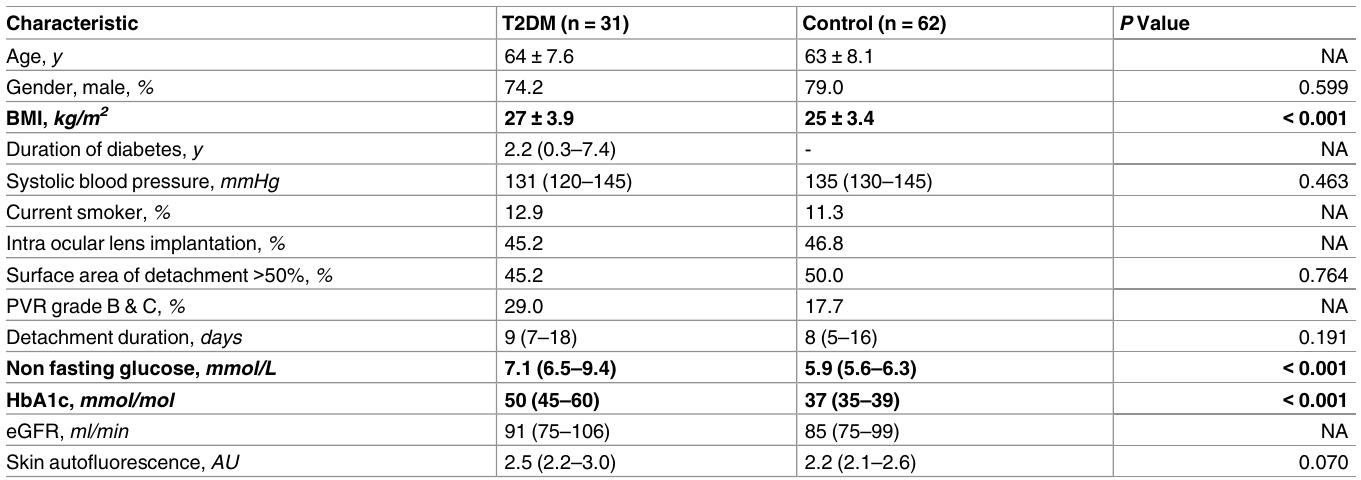
Table 1. Clinical characteristics of the study